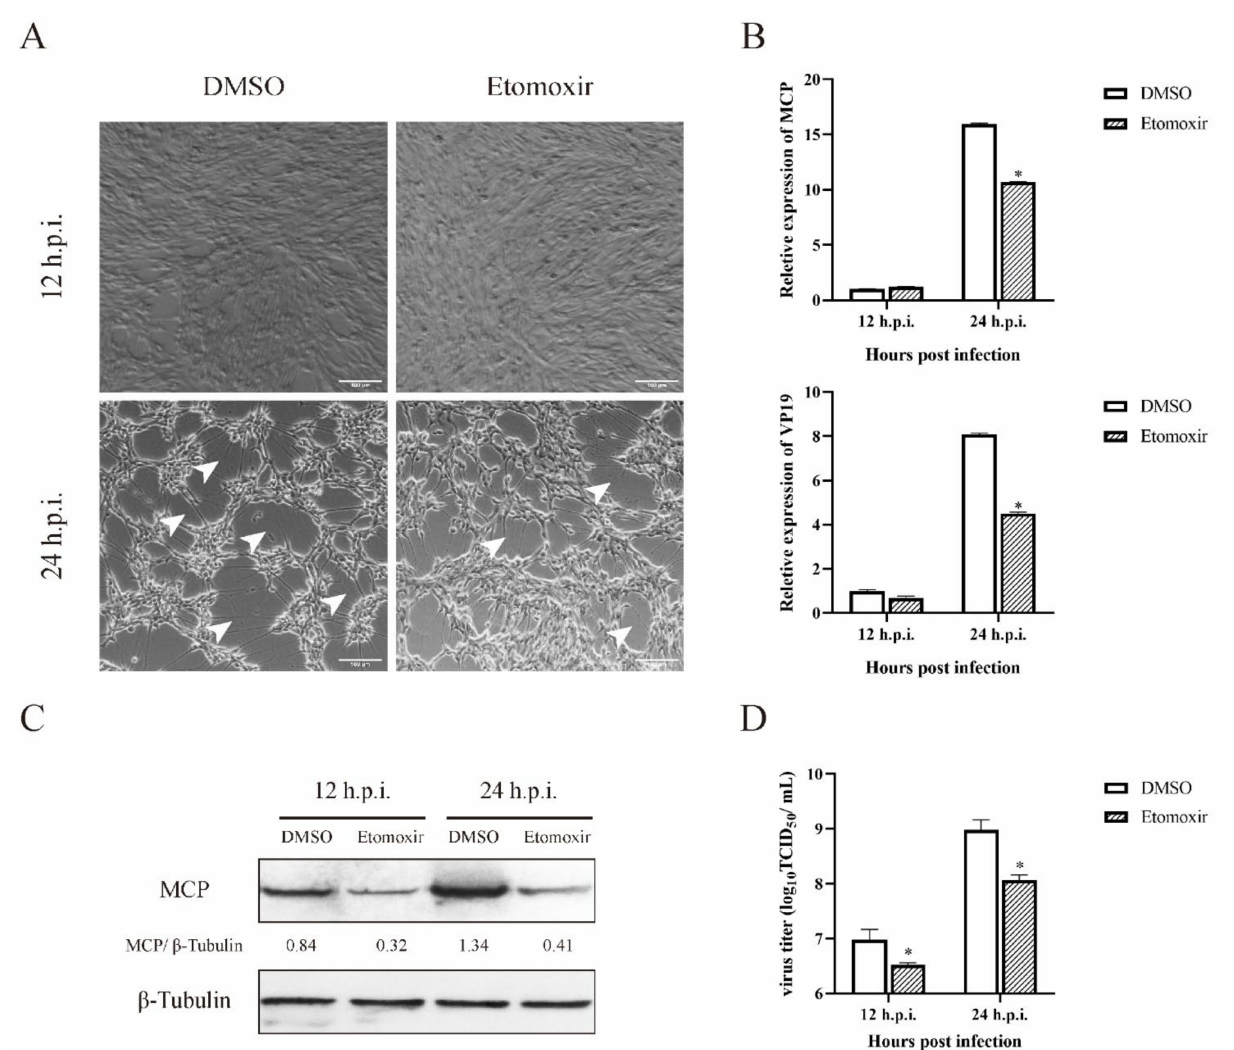
Figure 6. Roles of fatty acid β -oxidation during SGIV replication. CPE of GS cells under etomoxir during SGIV infection ( A ). Effects of etomoxir on SGIV genes transcription during SGIV infection ( B ). Effects of etomoxir on SGIV MCP protein expression during SGIV infection ( C ). Effects of Etomoxir on SGIV TCID 50 during SGIV infection ( D ). n = 3, data are expressed as means ± SD. * indicates p <